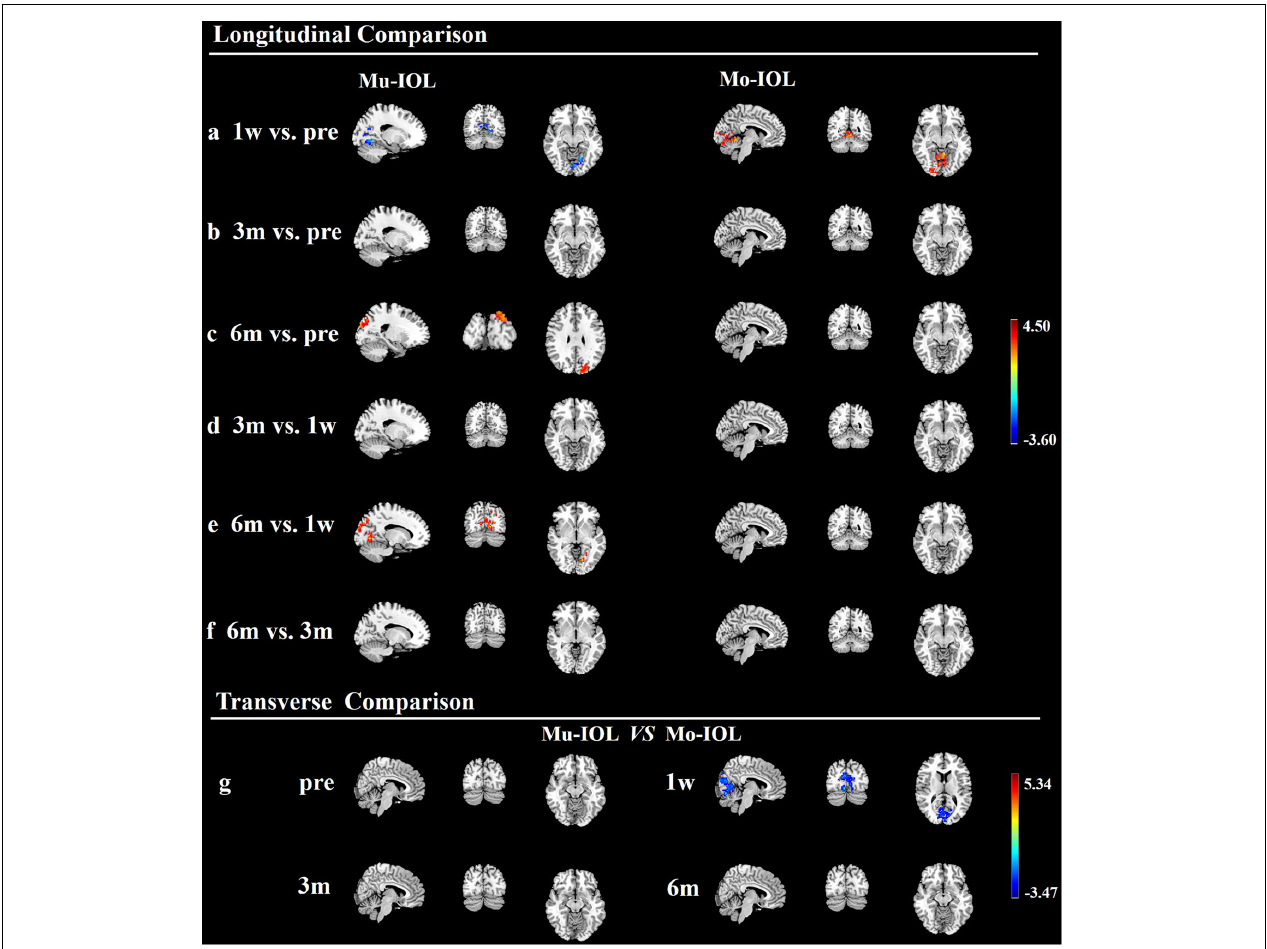
FIGURE 3 | Longitudinal and transverse comparisons of fractional amplitude of low-frequency fluctuations (fALFF) value in two groups. Surface maps show the fALFF value changes in the visual cortex between preoperative and postoperative time points (at a whole-brain threshold of P < 0.05, AlphaSim-corrected, voxels > 228, repeated measures (ANOVA) or between the Mu- and Mo-IOL groups (at a whole-brain threshold of P < 0.05, AlphaSim corrected, voxels > 228, two-sample t -tests). Slice overlays and plots represent the mean signals from the smoothed difference images for each cluster. Blue and cyan reflect decreases. Red and yellow reflect increases, and t indicates the peak t -score value for the t -test. (a) Compared with preoperative values, significantly decreased fALFF values in the Mu-IOL group, but increased values in the Mo-IOL group, in the lingual gyrus (BA17, BA18, and BA19) were observed at 1 week postoperation; (b) Compared with preoperative values, no significant difference was found in either the Mu- or the Mo-IOL group at 3 months postoperation; (c) Compared with preoperative values, significantly increased fALFF values in the Mu-IOL group in the cuneus (BA18 and BA19), but no significant difference in the Mo-IOL group, were observed at 6 weeks postoperation; (d) No significant difference was found in both Mu- and Mo-IOL groups between 1 week and 3 months postoperation; (e) Compared with 1-week postoperation value, significantly increased fALFF values in the Mu-IOL group in the lingual gyrus (BA17, BA18, and BA19) but no significant difference in the MO-IOL group was observed 6 weeks after surgery; (f) No significant difference was found in either the Mu- or the Mo-IOL group between 3 and 6 months postoperation; (g) Comparing the Mo-IOL group to the Mu-IOL group, significantly increased fALFF values in the lingual gyrus (BA17, BA18, and BA19) were reported only at 1 week postoperation. BA, Brodmann area; Mo-IOL, monofocal intraocular lens; Mu-IOL, multifocal intraocular lens; 1 w, 1 week postoperatively; 3 m, 3 months postoperatively; 6 m, 6 months postoperatively; pre, preoperatively.